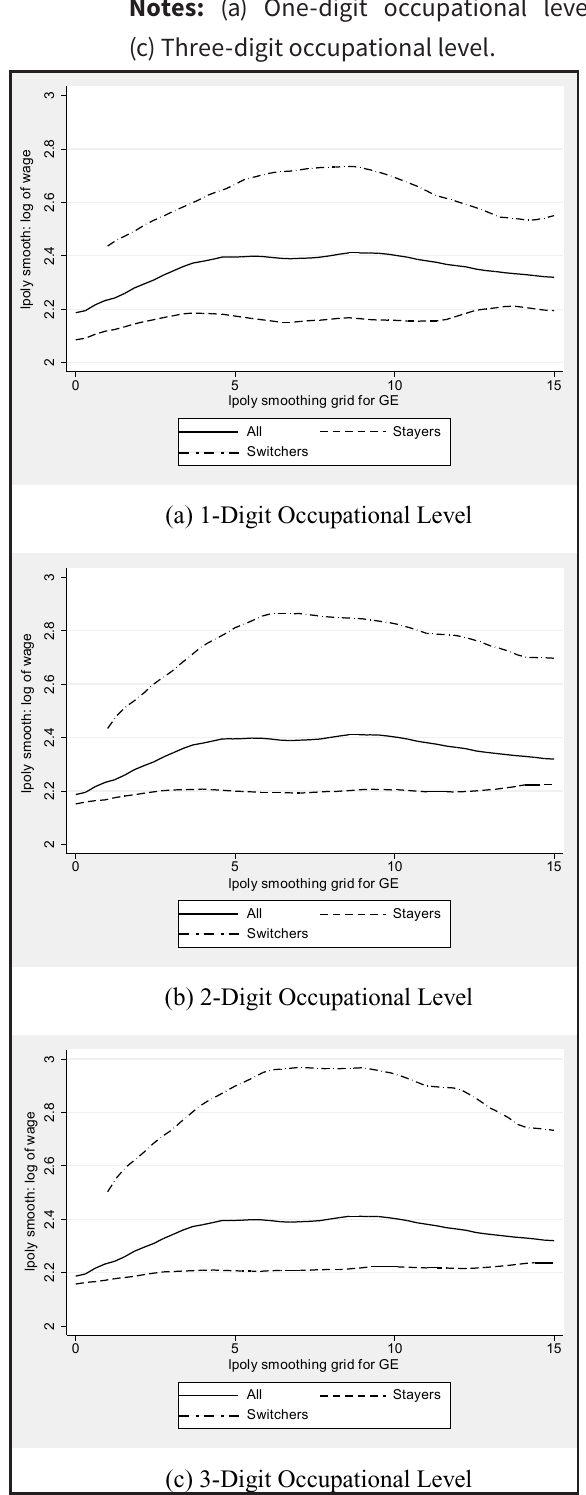
Figure 2 Kernel-weighted local polynomial – returns to general